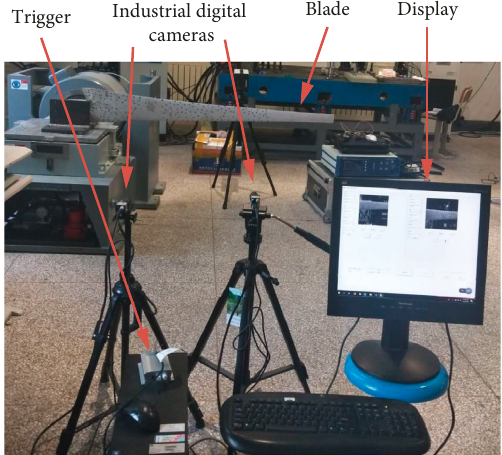
Figure 2: Experiment